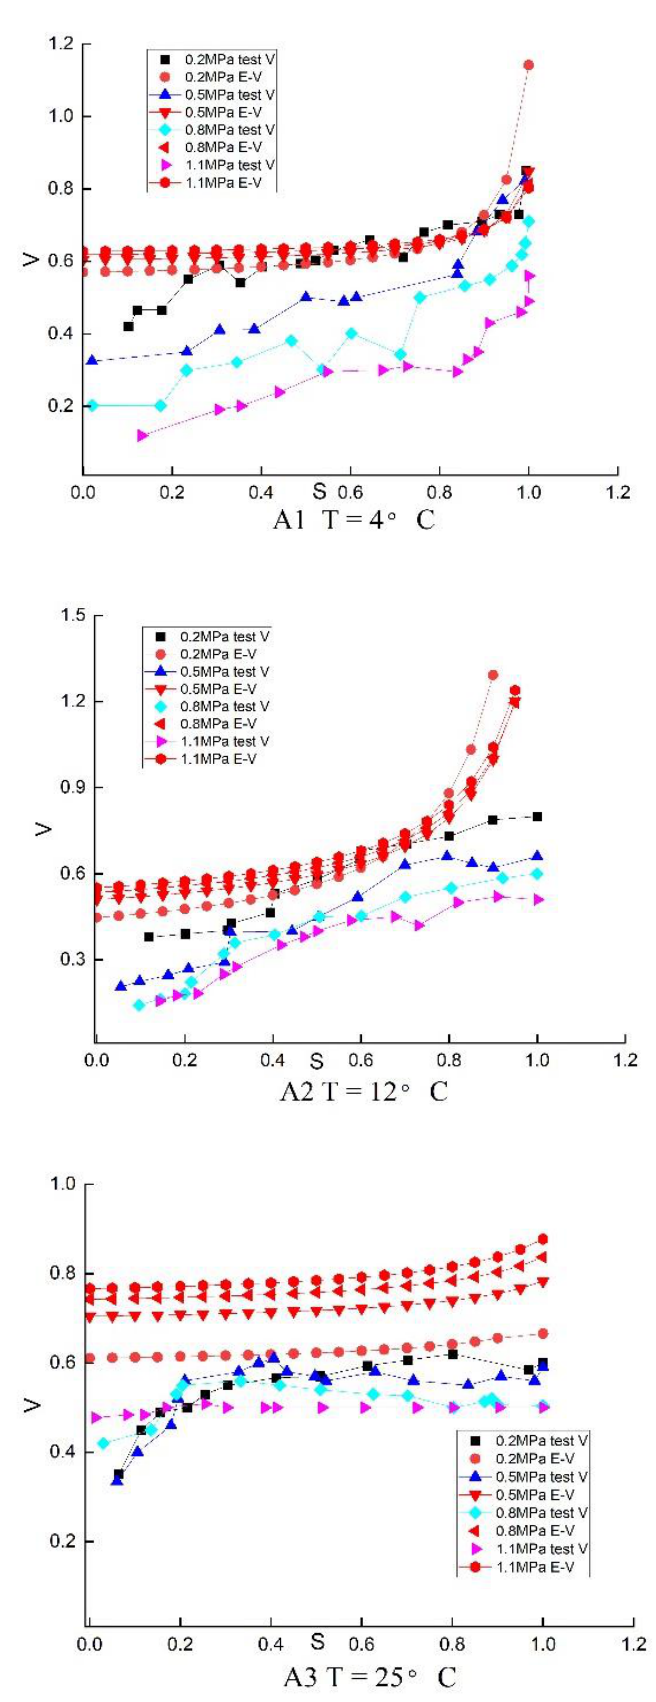
Figure 7. Poisson’s ratio of experimental and Duncan-Zhang E-v Figure 7 . Poisson’s ratio of experimental and Duncan -Zhang E-v model .